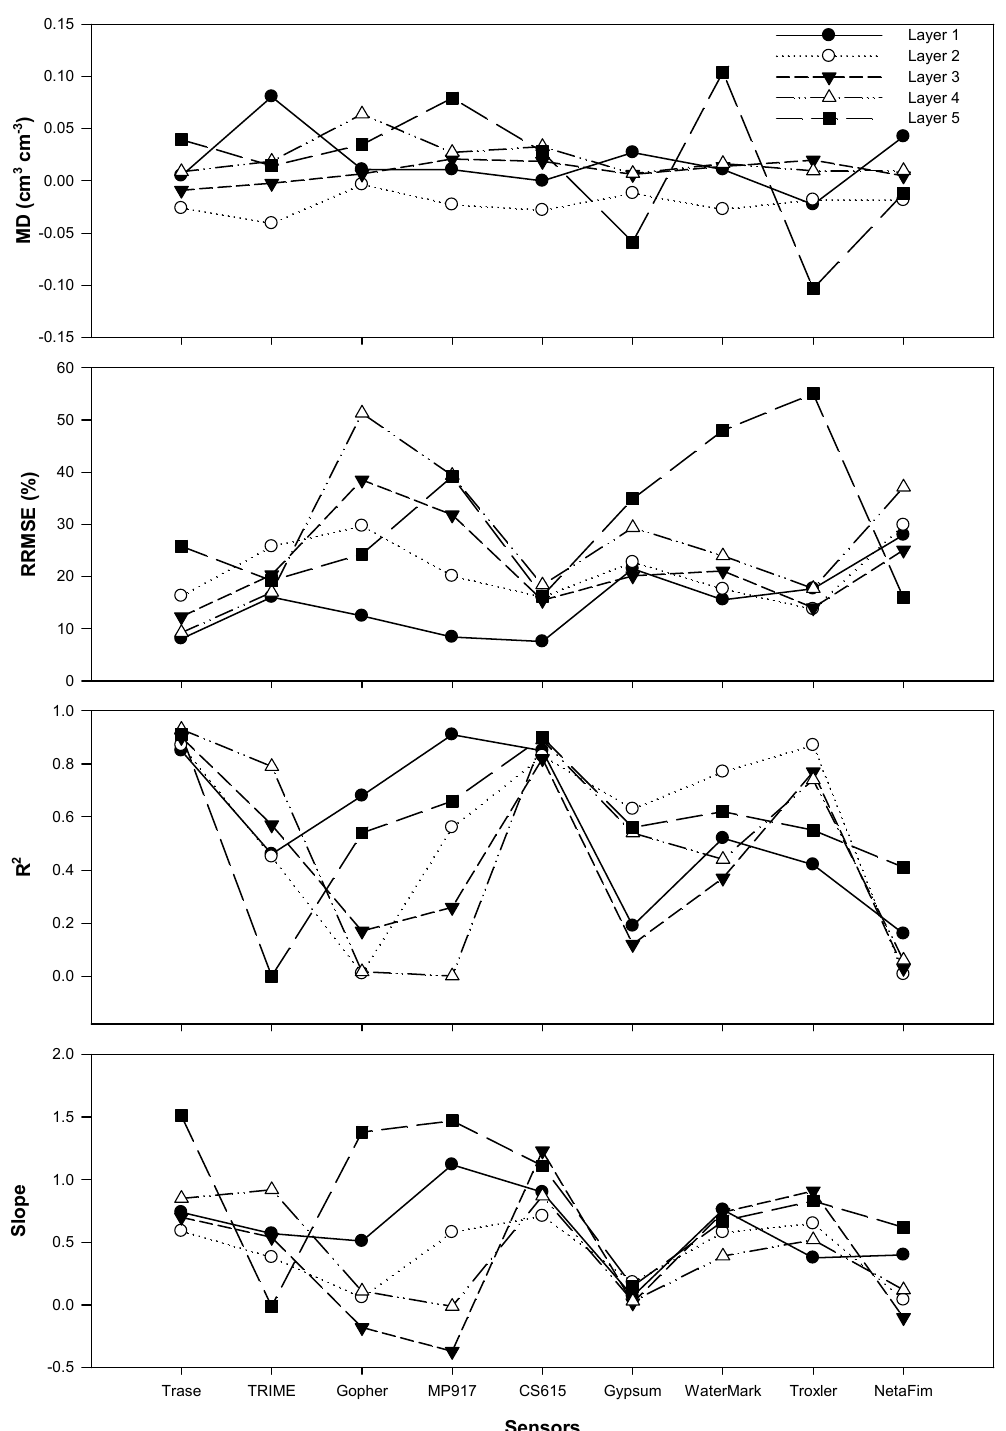
Figure 5. Comparisons of Mean Difference (MD), Relative Root Mean Square Error (RRMSE), Coefficient of Determination ( r 2 ), and regression slope obtained with different sensors at different soil layers with Gravimetric Method (GM) as